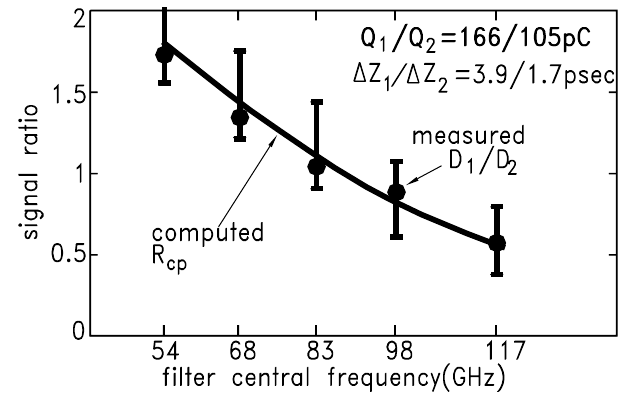
FIG. 11. Comparison of the computed R =D D for each channel (fixed wavelength) for two different 1 2 bunch lengths (3.9 and 1.7 psec) and charges (166 and 105 pC). The solid black line is the computed R bunch charges, and rms lengths by an independent technique. The dots represent the measured D from one shot to another is measured by calculating the charge variation from the signal variation of the